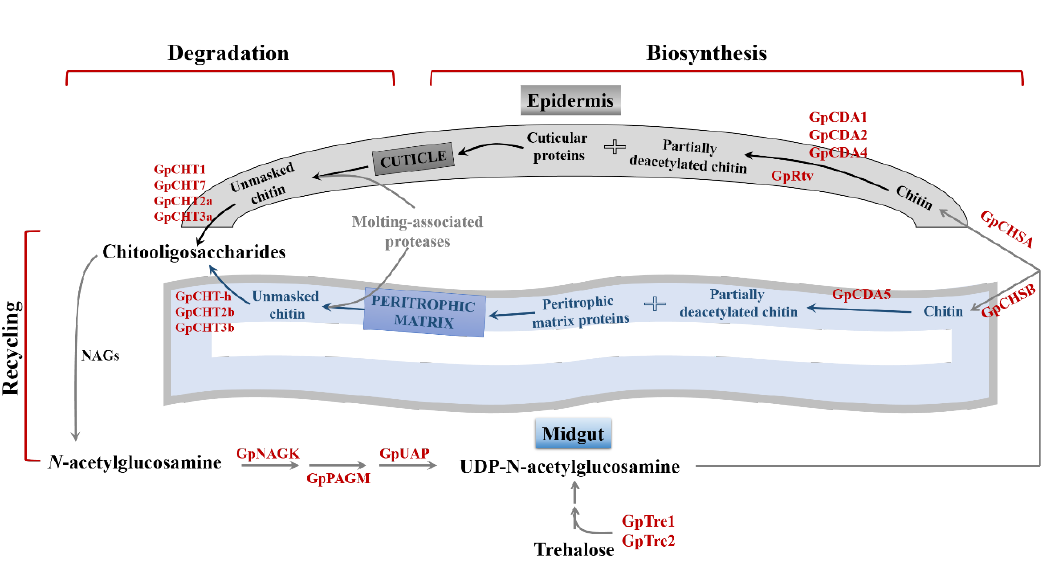
Figure 8. The hypothesis of the main processes, key enzymes, and proteins involved in chitin Figure8. Thehypothesisofthemainprocesses, keyenzymes, andproteinsinvolvedinchitinmetabolism metabolism in G. pyloalis . Abbreviations: Tre1 and Tre2, trehalase 1 and 2; PAGM, N- in G. pyloalis . Abbreviations: Tre1 and Tre2, trehalase 1 and 2; PAGM, N-phosphoacetylglucosamine phosphoacetylglucosamine mutase; CHSA and CHSB, chitin synthase A and B; CDA1, 2, 4, and 5, mutase; CHSA and CHSB, chitin synthase A and B; CDA1, 2, 4, and 5, chitin deacetylase1, 2, 4, and 5; Rtv, retroactive; CHT1, 2a, 2b,3a,3b, 7, and h, chitinase 1, 2a, 2b,3a,3b, 7, and h; NAGK, N -acetyl- d -glucosamine kinase; UAP, UDP- N -acetylglucosamine